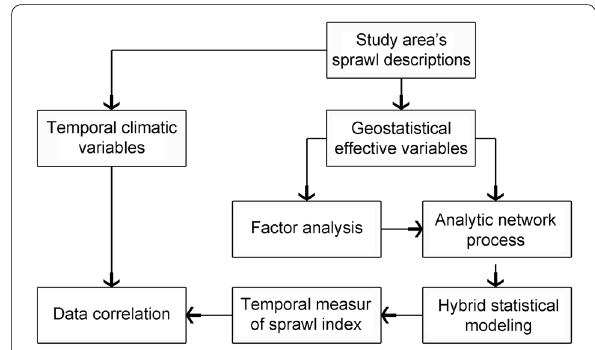
Fig. 2 Urban sprawl modeling of the present